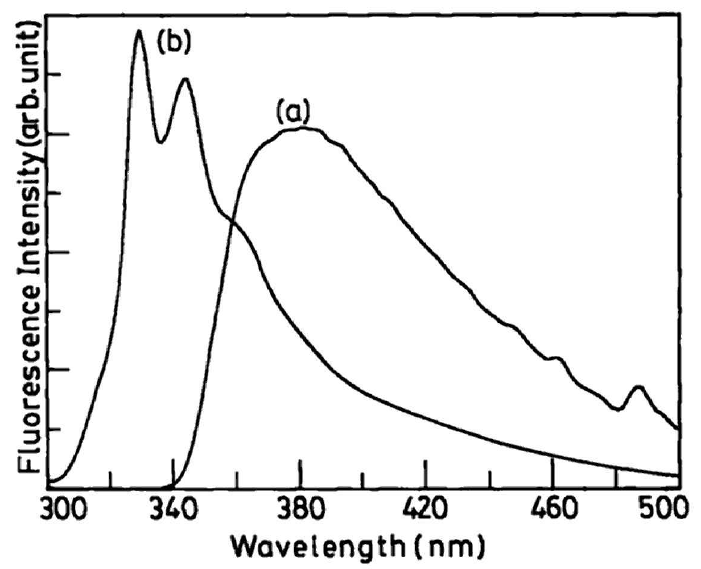
Fig. 3 Florescence spectra of the trimer, T, using ca 10 ¡ 4 M concentrations, 5 nm emission band pass and 10 nm excitation band pass in (a) TFA ( ¶ exe = 277nm) and (b) DMSO ( ¶ exe =